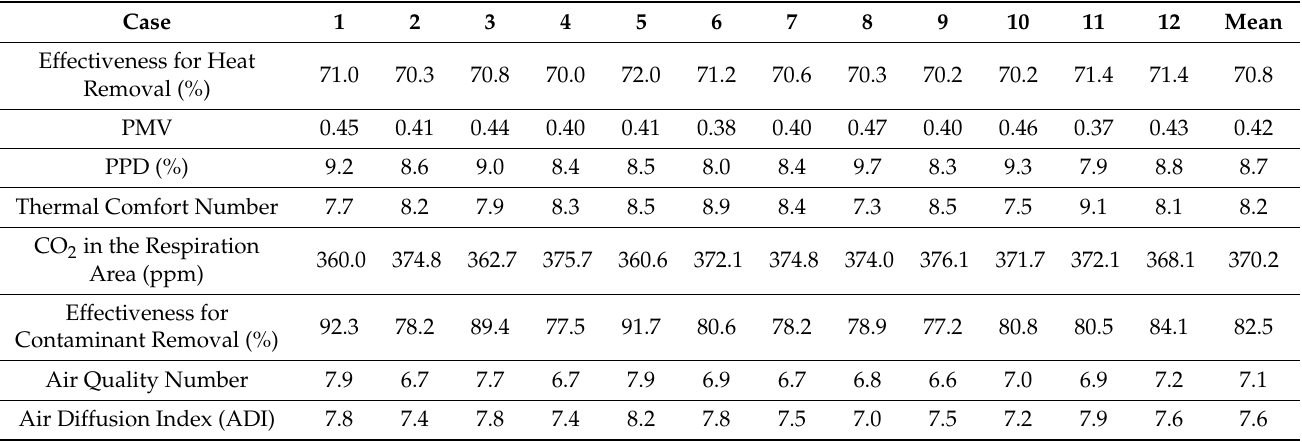
Table 9. ADI obtained for Case III (0.1556 m 3 /s) at 10 h.